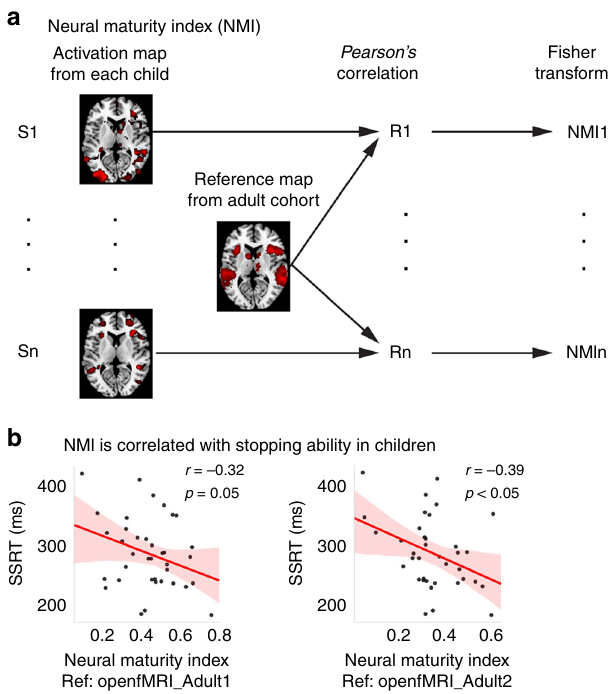
Fig. 6 NMI predicts stopping action in children. a Schematic illustration of the algorithm used to compute a neural maturity index (NMI) in each child. We computed the spatial correlation between each child ’ s activation map and a reference activation map from each of the adult cohorts using Pearson ’ s correlation and a Fisher transformation was used to determine the NMI for each child. b NMI in children was negatively correlated with stop signal reaction time (SSRT). This relationship was replicated using reference maps from the two adult cohorts. Source data are provided as a Source Data fi le